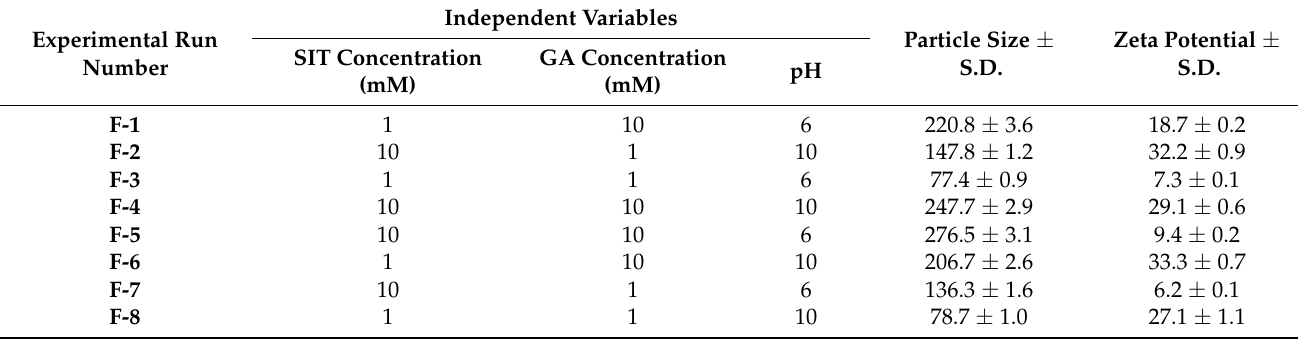
Table 1. Experimental runs and the observed responses of the SIT-GA nano-conjugates prepared according to a 2 3 factorial design. Experimental Run